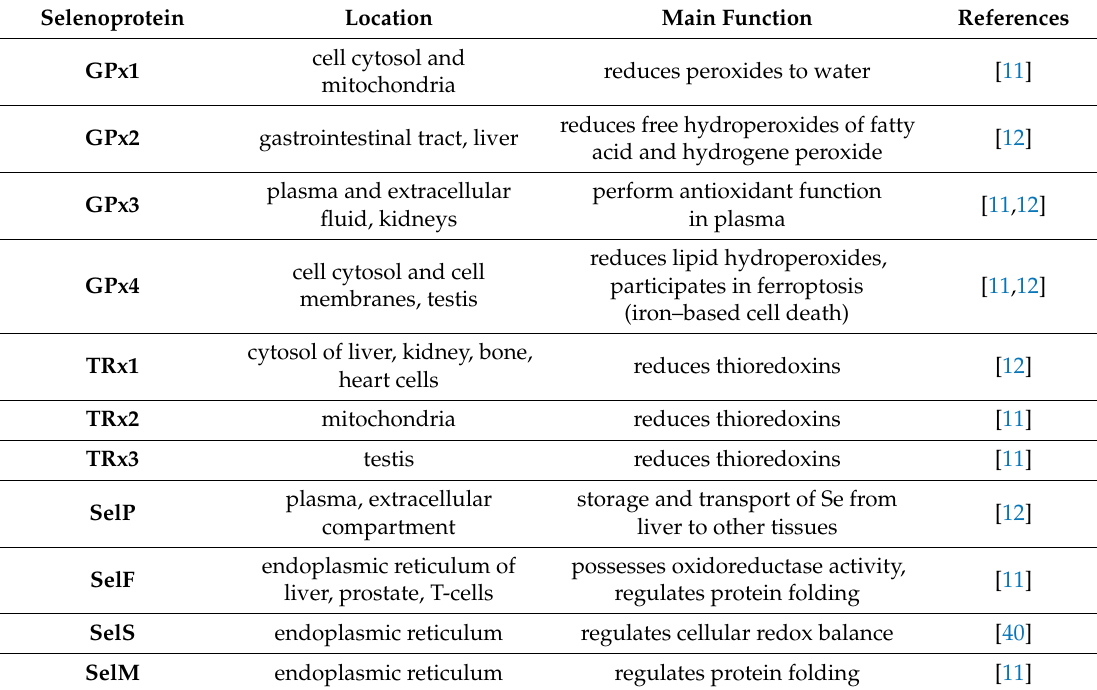
Table 1. Redox active selenoproteins, their location and main